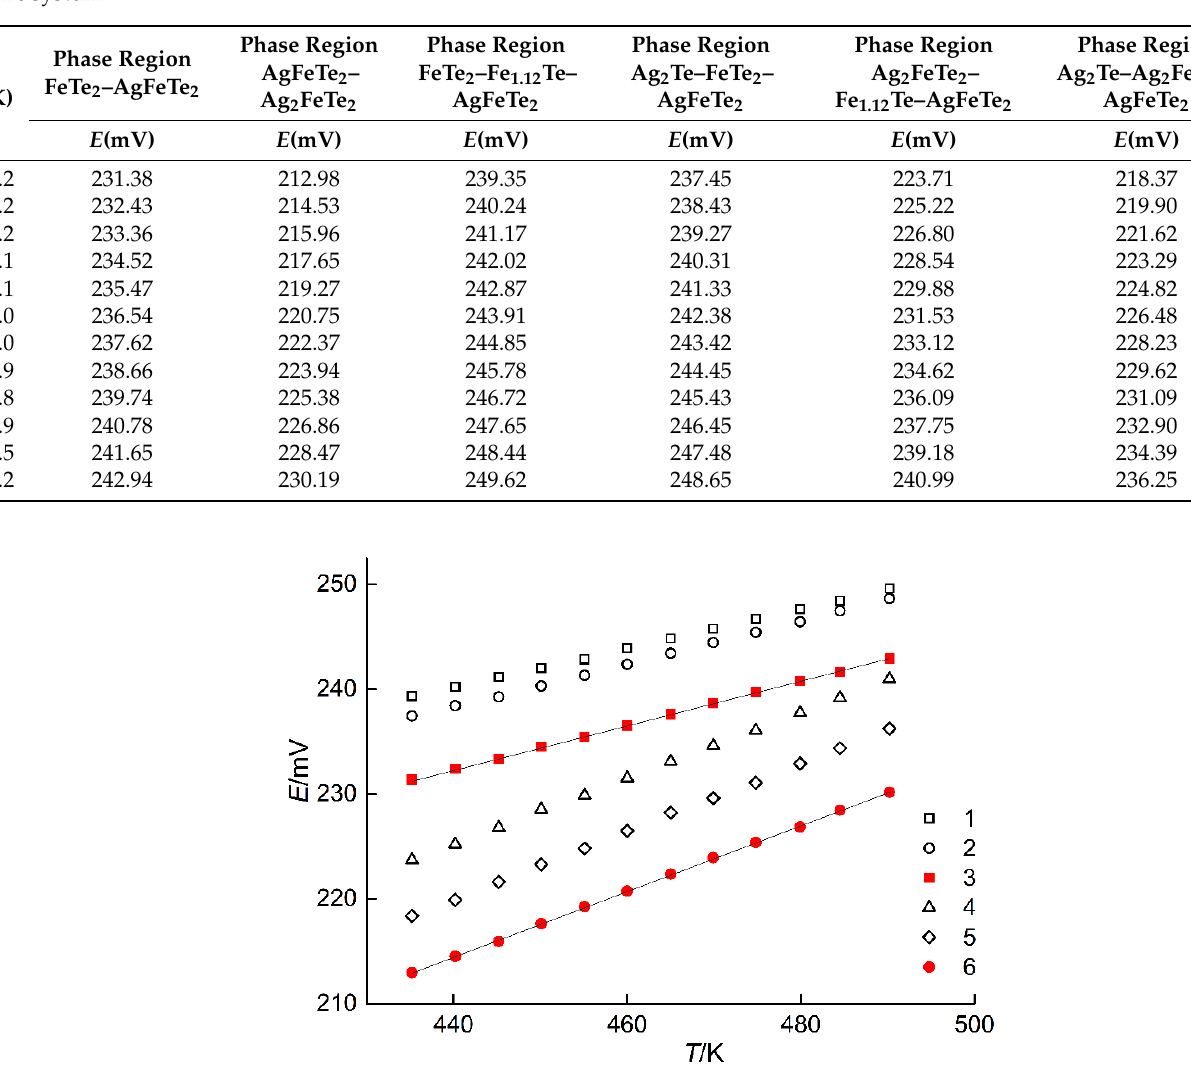
Table 1. A summary of the measured temperatures and EMF values of the ECCs in different phase regions of the Ag–Te–Fe system.